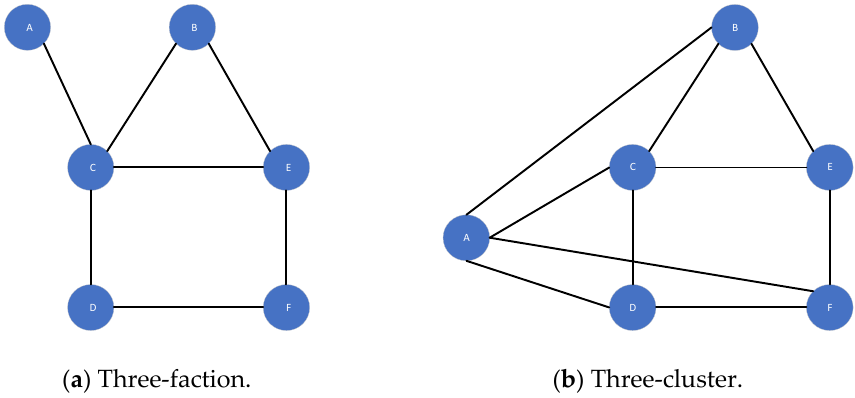
Figure 2. Structural features of faction analysis and K-cluster analysis.